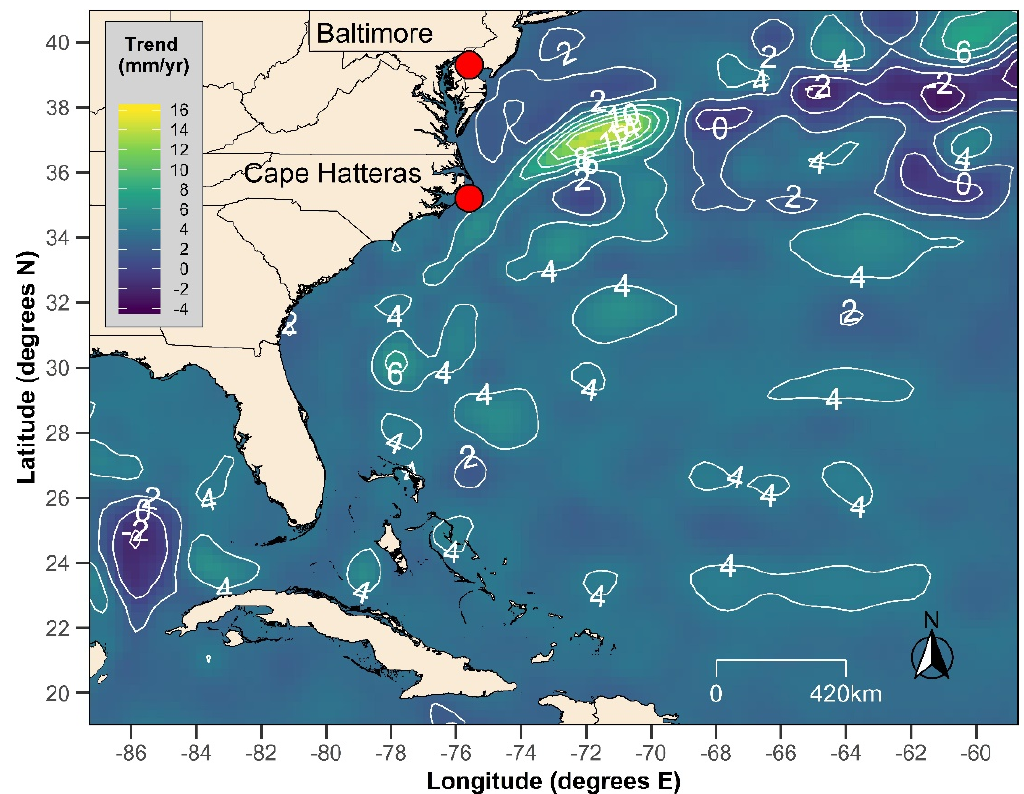
Figure 9. Panel 3—SSHA Trends (September 1992–October 2019) from AVISO data [30]. Trend contours are advised at 2 mm/year intervals. Refer also to Figure 6.